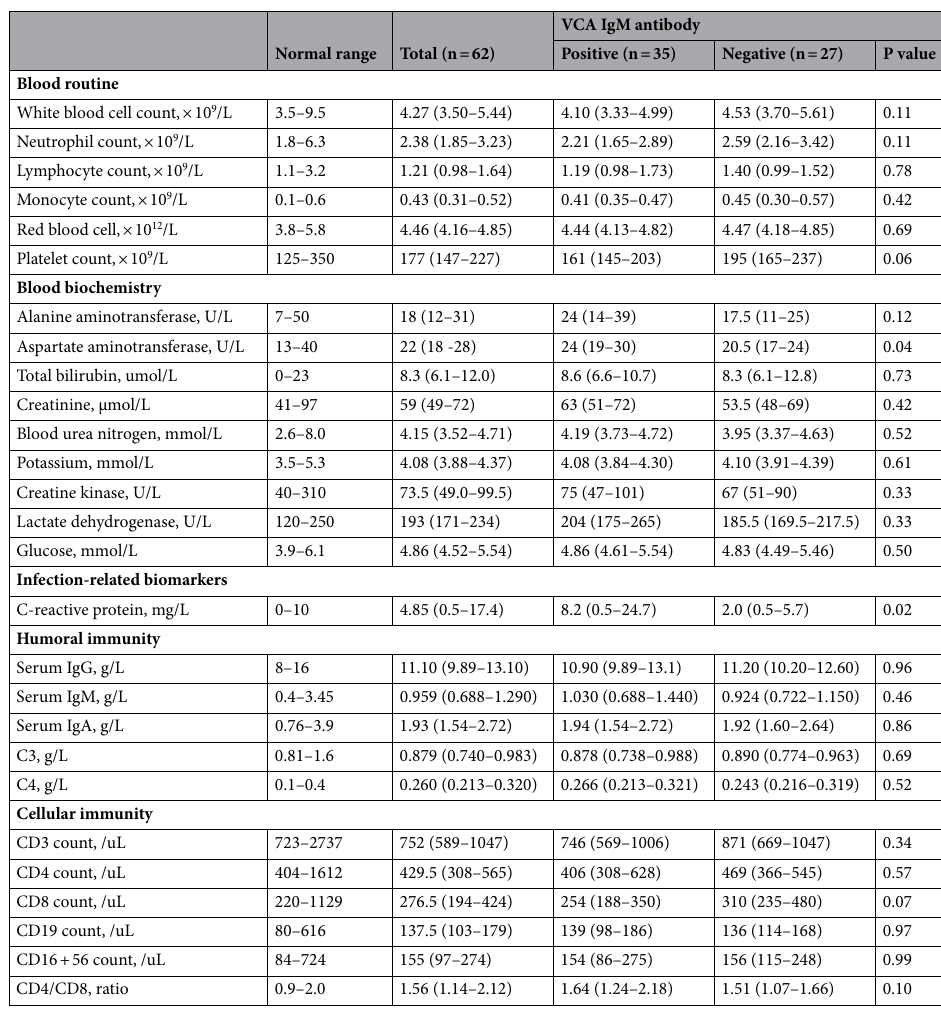
Table 2. Laboratory findings of Epstein–Barr virus (EBV)/severe acute respiratory syndrome coronavirus 2(SARS-CoV-2) coinfection and SARS-CoV-2 infection alone patients.